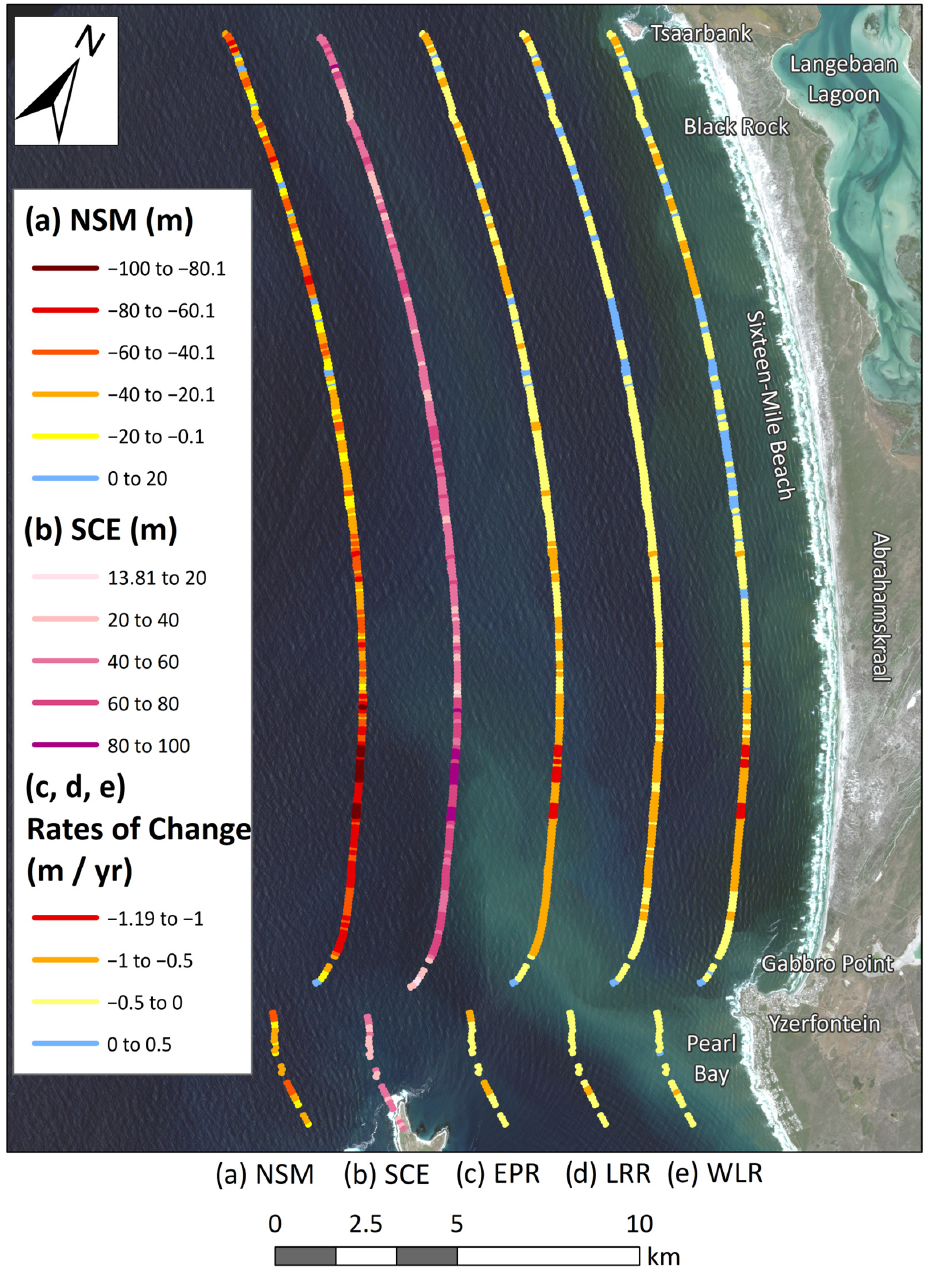
Figure 6. Summary of DSAS results showing ( a ) the Net Shoreline Movement (NSM), ( b ) Shoreline Change Envelope (SCE), ( c ) End Point Rate (EPR), ( d ) Linear Regression Rate (LRR), and ( e ) the Weighted Linear Regression (WLR).